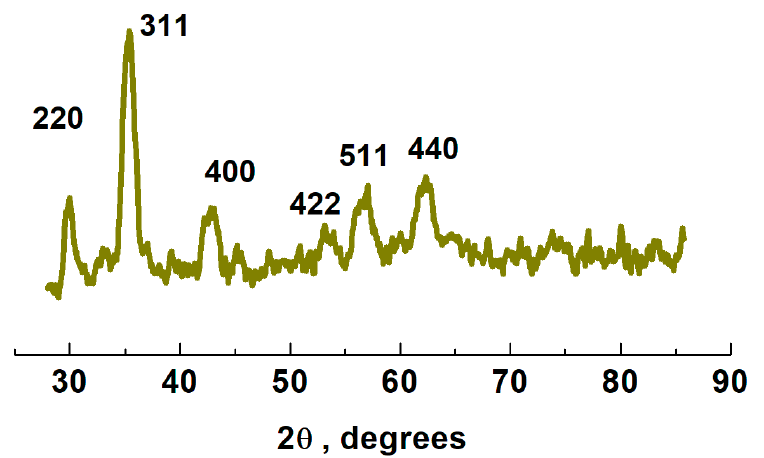
Figure 3. XRD pattern of γ -Fe 2 O 3 MNPs synthesized using a combination of surfactants (SDS and PEG) at 180 °C for 24 h.